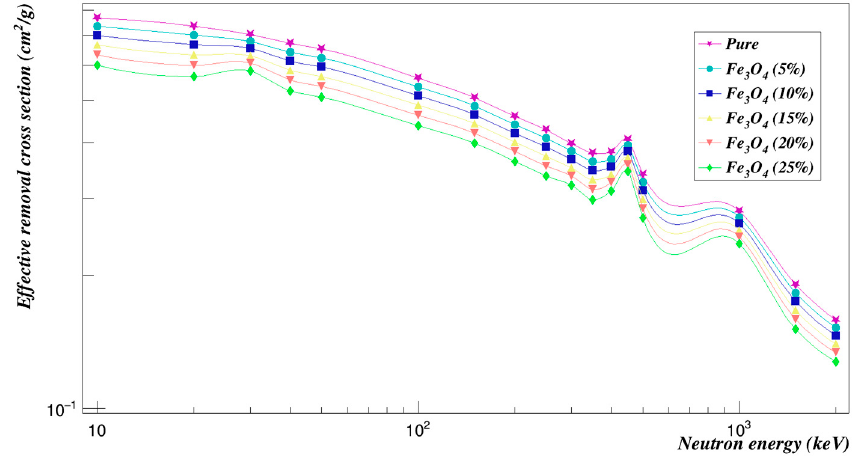
Figure 7. Neutron e ff ective removal cross sections of Polyimide doped with iron oxide. Figure 7. Neutron effective removal cross sections of Polyimide doped with iron